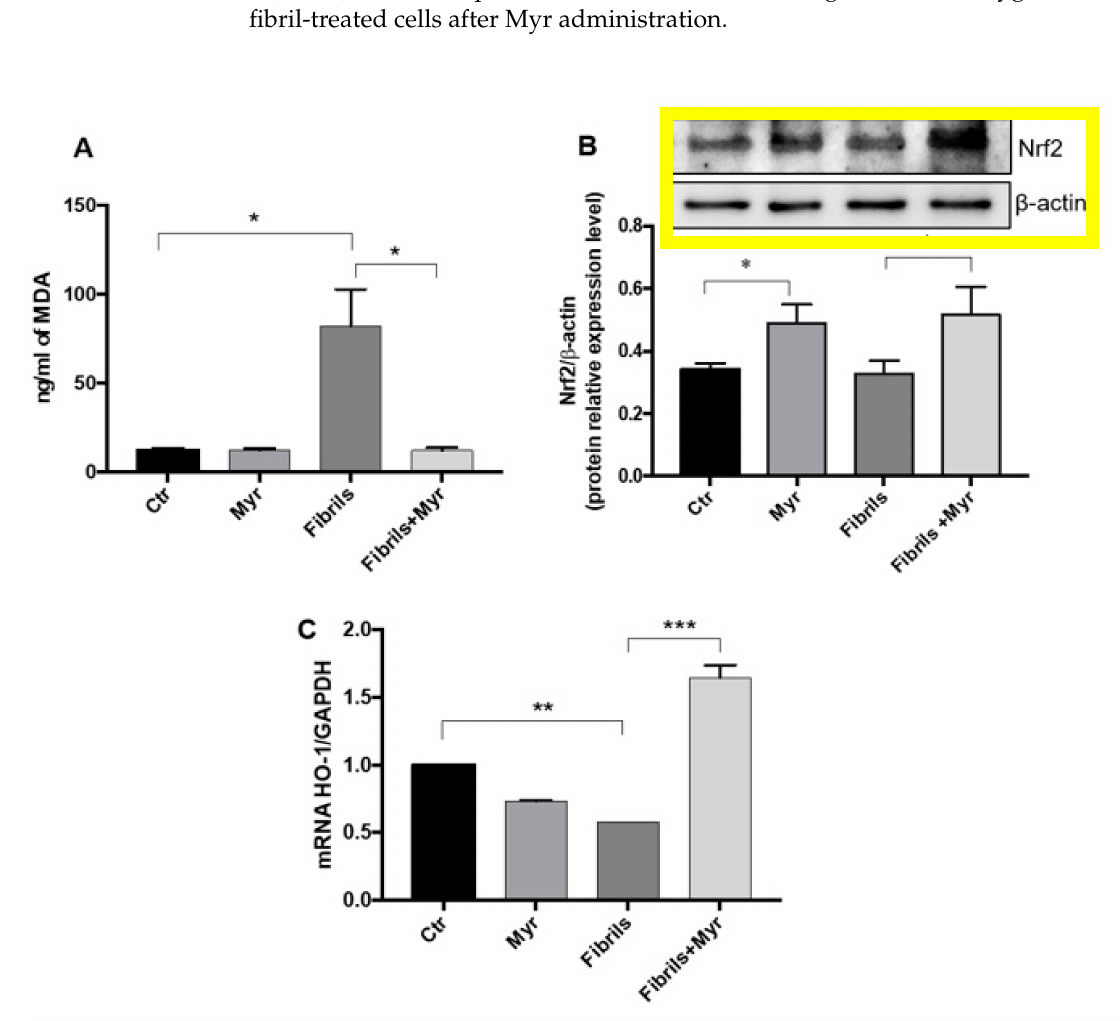
Figure 5. Myr treatment reduces oxidative stress in the PD cell model. ( A ) Measurement of lipid peroxidation in cell supernatant using MDA ELISA kit on SH-SY5Y cells treated with 0.5 µ M α -syn fibrils for 24 h with or without 50 µ M Myr pretreatment. ( B ) Quantification of Nrf2 protein expression by Western blot analysis on whole lysates and normalized to β -actin. Protein signals were quantified by densitometric analysis. ( C ) Quantification of HO-1 gene expression by qRT-PCR. GAPDH was used as a housekeeping gene. All data, derived from three independent experiments, are expressed as mean ± SEM (* p < 0.05; ** p < 0.01; *** p < 0.001); one-way ANOVA test followed by Bonferroni correction was used for all